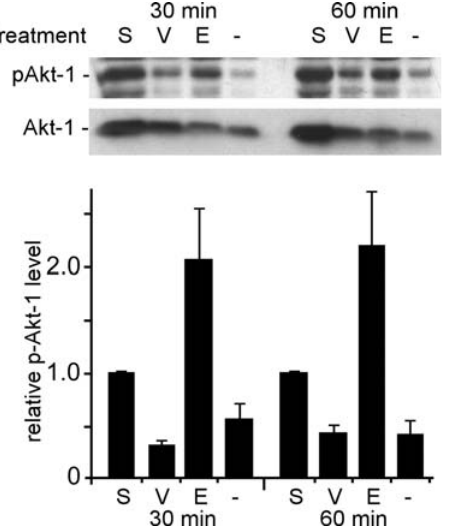
Figure 2. ZEBOV particles induce Akt-1 phosphorylation early during infection. Serum-starved HEK293 cells were incubated with serum-free medium ( 2 ), medium containing 10% FBS (S), and serum- free medium containing c -radiation–inactivated ZEBOV (E, MOI=5) or VSV (V, MOI=5) at 37 u C for 30 or 60 min. Subsequently, cells were washed and lysed, and phosphorylated Akt-1 was detected by Western blotting (p-Akt-1; top panel). The same membrane was then stripped and re-probed for total Akt-1 (bottom panel). The bar graph shows a summary of densitometry analysis of bands, which was performed using the ImageJ gel analysis package. The ratio of band intensities of phospho-Akt-1 to total Akt-1 was determined and normalized to the serum-treated control. Each data point represents mean 6 SD of 3 experiments.